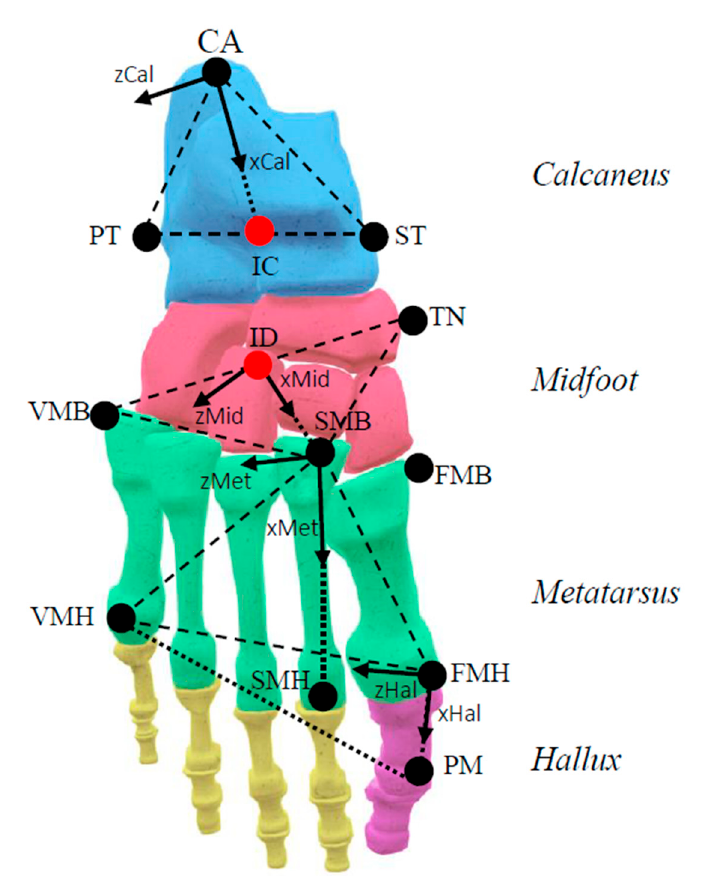
Figure 1. Diagram of the analyzed foot segments with relevant anatomical landmarks and coordinate reference frames (see Leardini et al., 2007). These were assumed to be rigid segments. CA: upper central ridge of the calcaneus posterior surface, ST: medial apex of the sustentaculum tali, PT: lateral apex of the peroneal tubercle, TN: medial apex of the tuberosity of the navicular, VMB: base of the fifth metatarsal, dorsolateral aspect of the fifth metatarso-cuboid joint, FMB: base of the first metatarsal, dorsomedial aspect of the first metatarso-cuneiform joint, VMH: Head of the fifth metatarsal, dorsolateral aspect of the fifth metatarsophalangeal joint, FMH: head of the first metatarsal, dorsolateral aspect of the first metatarsophalangeal joint, SMH: Head of the second metatarsal, dorsomedial aspect of the second metatarsophalangeal joint, SMB: second metatarsal base, assumed to coincide with the most distal and dorsal aspect of the middle cuneiform, PM: Most distal and dorsal point of the head of the proximal phalanx of the hallux, IC: midpoint of the straight line between PT and ST, ID: midpoint of the straight line between TN and